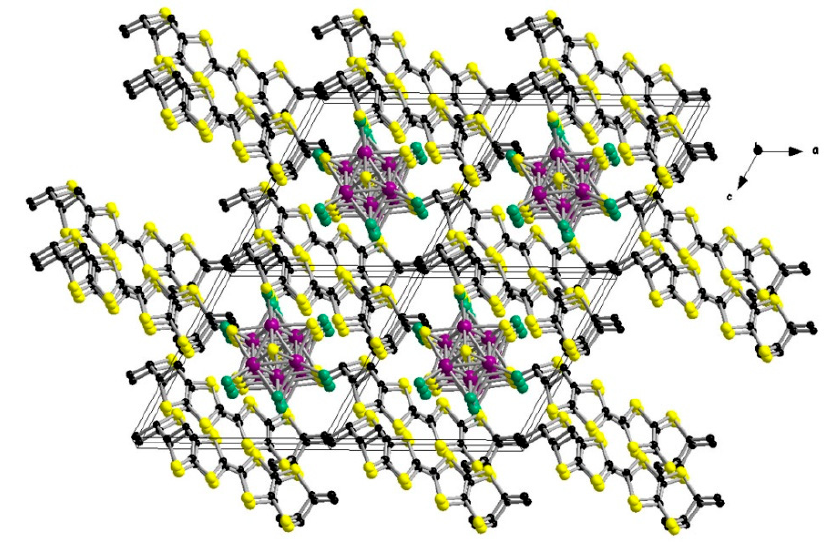
Figure 4. Packing diagram of [( S )- 1 ] 2 ·Re 6 S 6 Cl 8 in the ac plane.